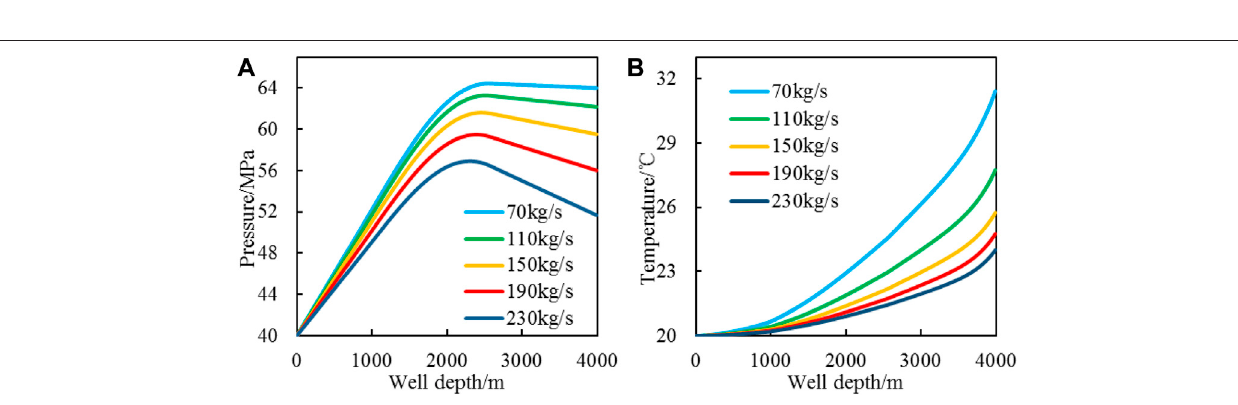
Frontiers in Earth Science |